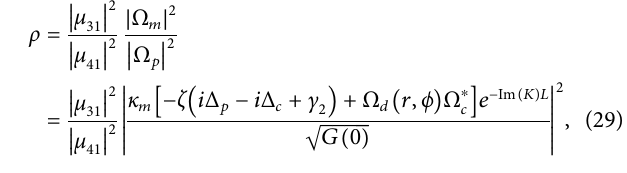
Frontiers in Physics |